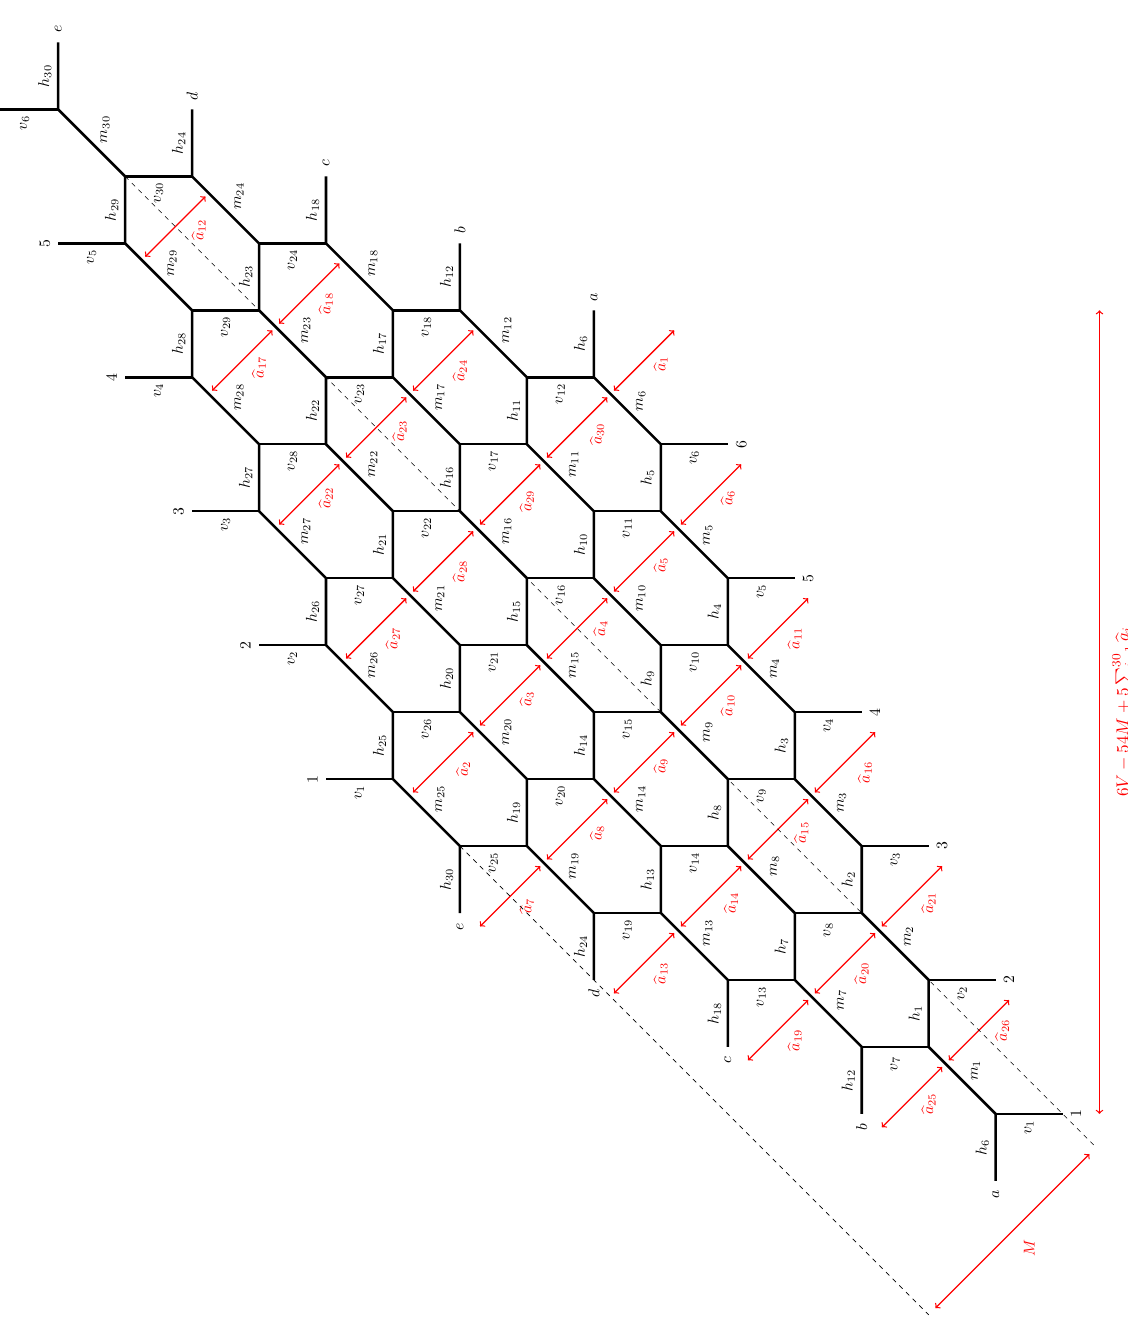
Figure 5 . Parametrisation of the (6 ; 5) web diagram: out of the 90 curves ( h i ; v i ; m i ) (for i = 1 ; : : : ; 30) only 32 parameters are independent. The red curves constitute a maximal set of independent parameters which makes a U(30) symmetry visible.